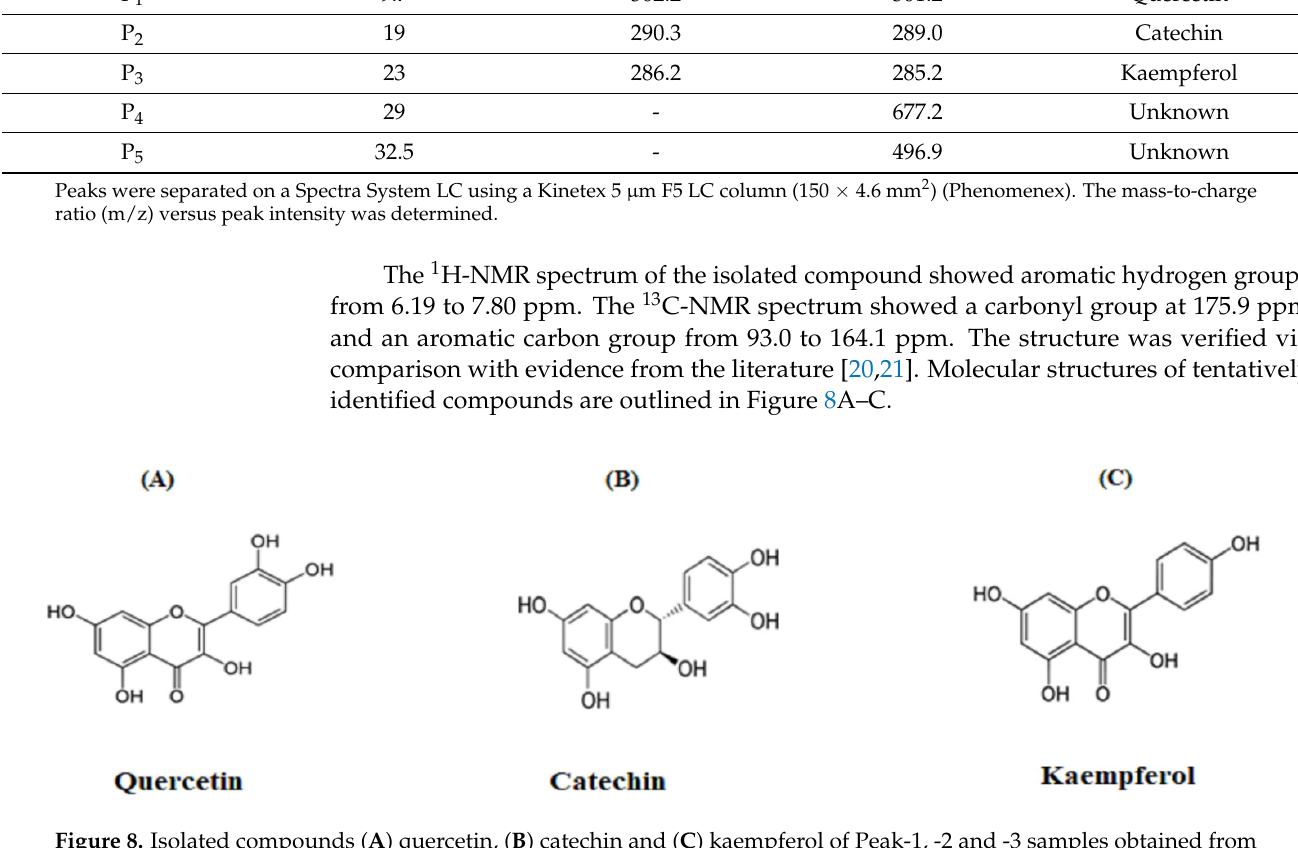
Figure 9B) from BRIN-BD11 cells. At concentrations ≥ 100 µ M, this was associated with cytotoxicity and increased LDH release by 1.25-fold (Figure